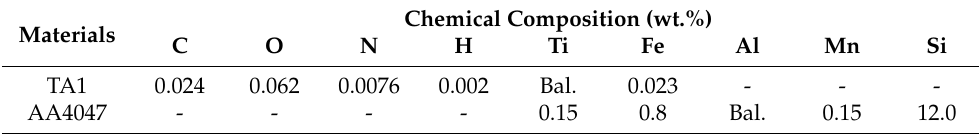
Table 2. Mechanical properties of the raw materials.